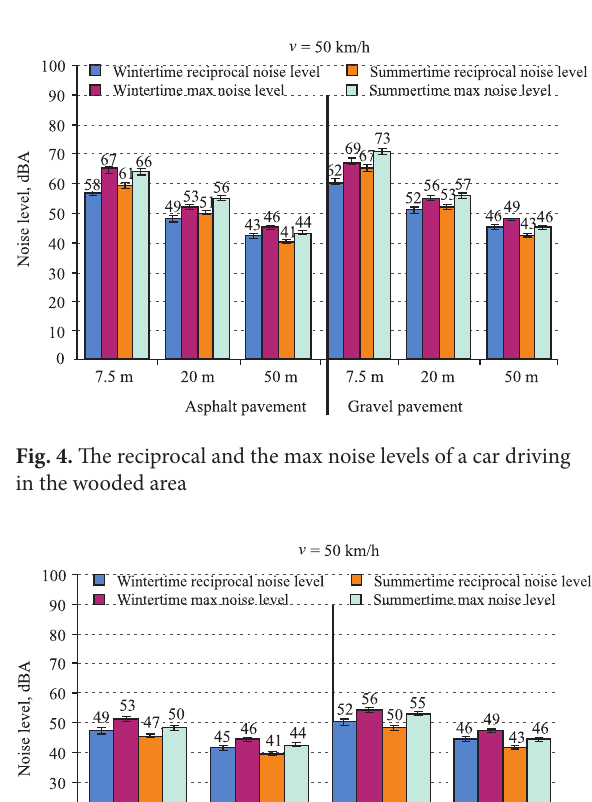
Fig. 3. Th e reciprocal and the max noise levels of a car driving in an open area